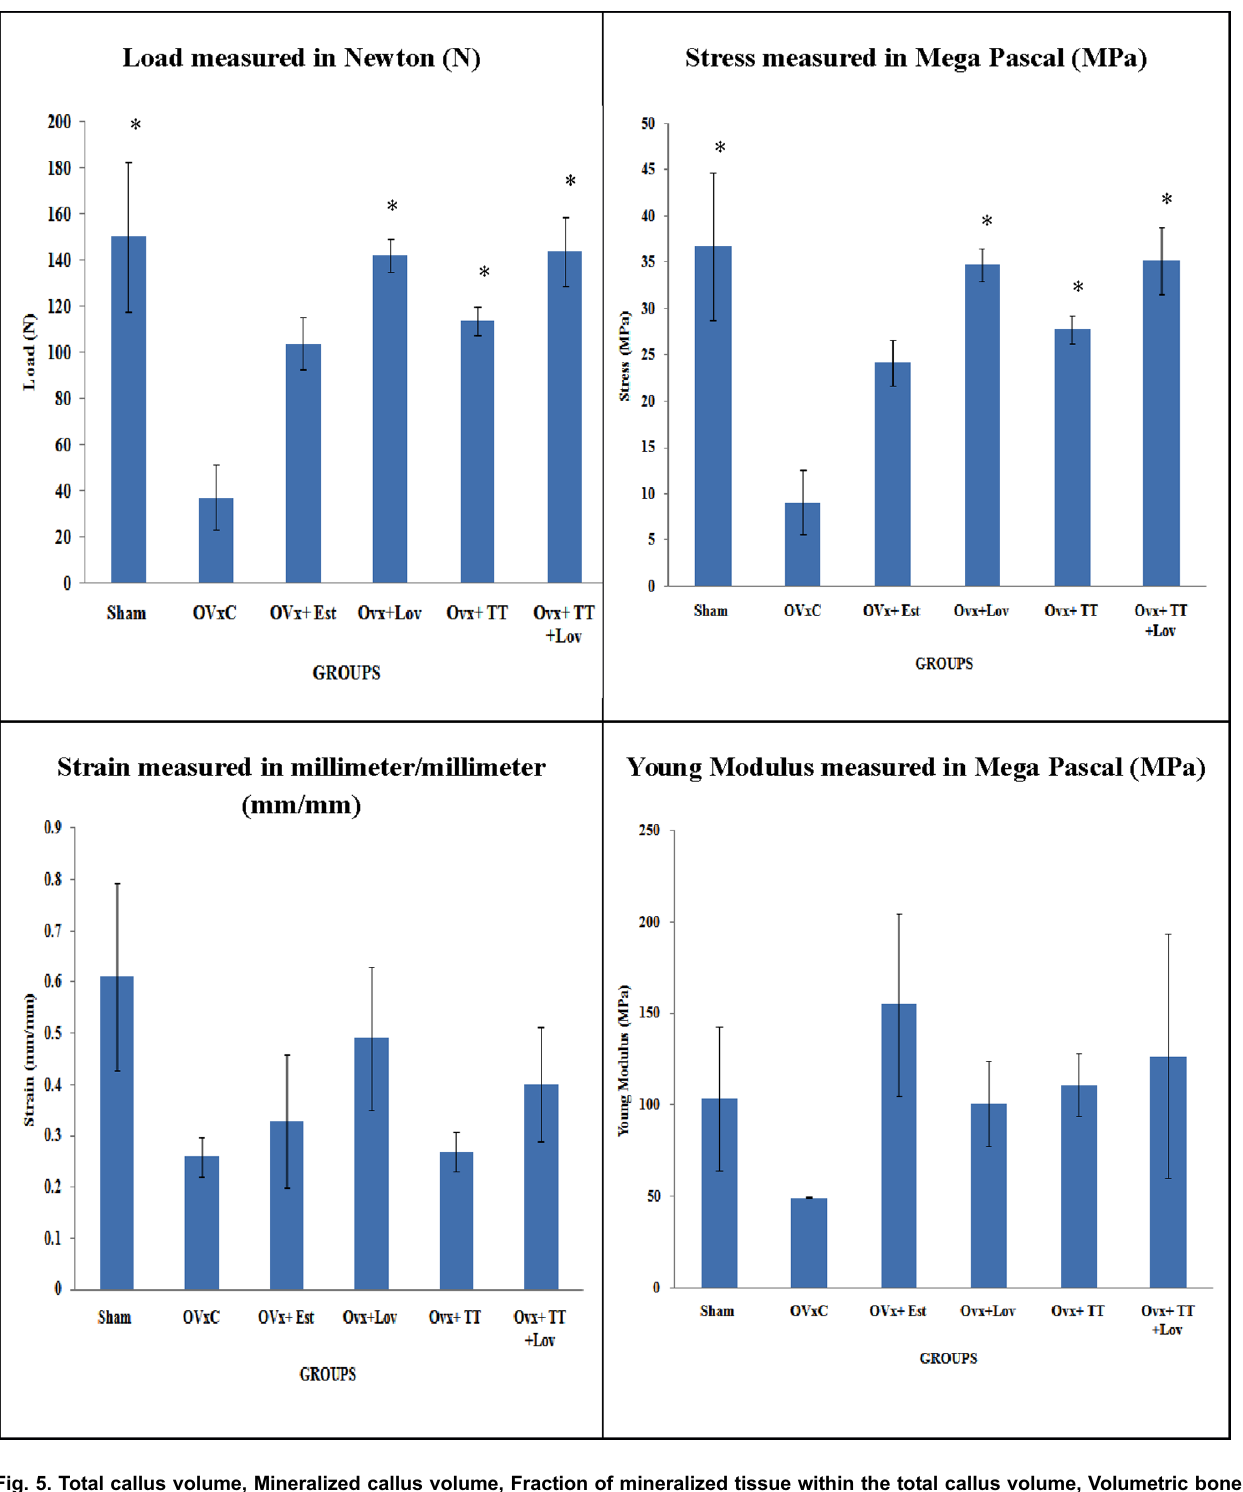
Fig. 5. Total callus volume, Mineralized callus volume, Fraction of mineralized tissue within the total callus volume, Volumetric bone mineral density for all the groups after 4 weeks of treatment. Sham: sham-operated group, OVxC:ovariectomized control group, OVx + Est:ovariectomized + Estrogen, OVx + Lov:ovariectomized + Lovastatin, OVx + TT:ovariectomized + Tocotrienol, OVx + TT + Lov:ovariectomized + Tocotrienol + Lovastatin. *Indicates a significant difference (p , 0.05) compared with the ovariectomized control group (OvxC). The data were expressed as mean ¡ SEM.